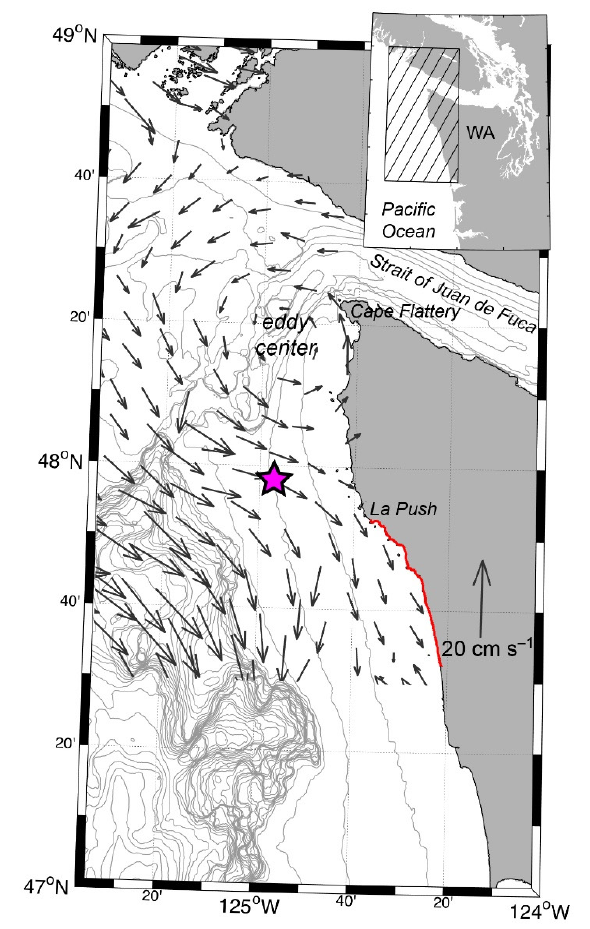
Figure 1. Map of the U.S. Pacific Northwest coast showing the location of the Northwest Enhanced Moored Observatory (NEMO; pink star) with Environmental Sample Processor (ESP) on the Washington shelf. Surface velocities are four-day averaged values at 4-m depth for September 2003 from diagnostic model output reported in MacFadyen et al. [34] , with the center of the Juan de Fuca eddy labeled for this specific flow field. The Jefferson County, WA shoreline is indicated in red. Bathymetry contours (gray) are every 50 m.